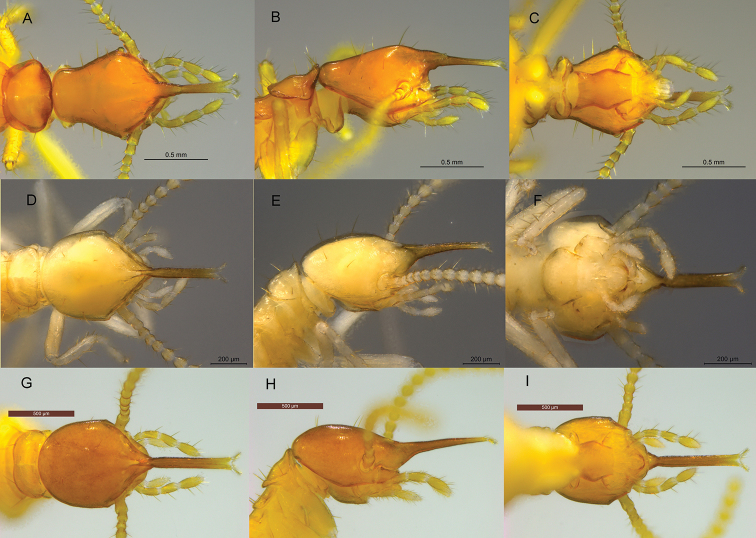
Minor soldiers of Neotropical Rhinotermitinae deposited in UF and CATAC termite collections A–CAcorhinotermes
subfuscicepsD–FDolichorhinotermes
longidensG–IDolichorhinotermes
lanciarius.